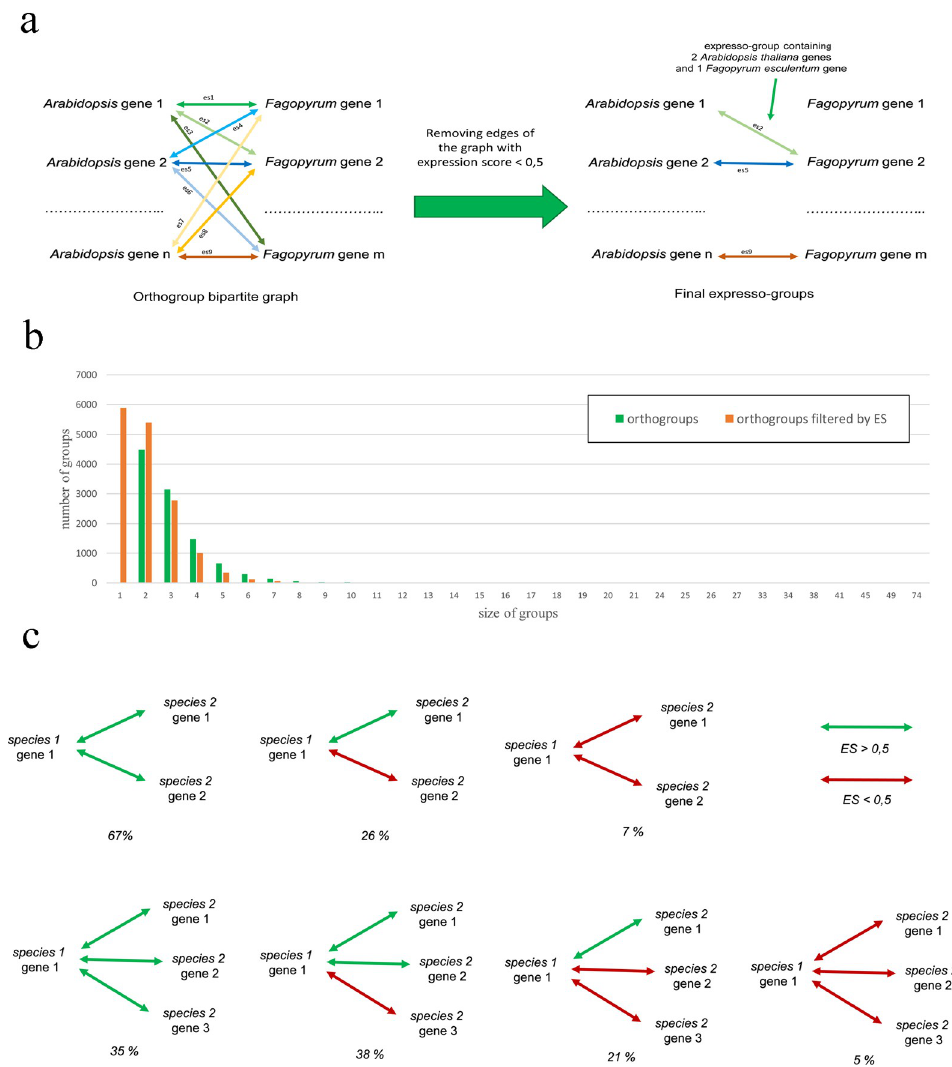
Fig 2. Development and testing of the ISEEML pipeline. (a) Construction of expresso-groups by fractionation of the orthogroups using ES cut-offs. (b) Distribution of sizes of the orthogroups and expresso-groups. (c) Different types of fractionation of the orthogroups and their frequencies for orthogroups with two (upper panel) and three (lower panel)